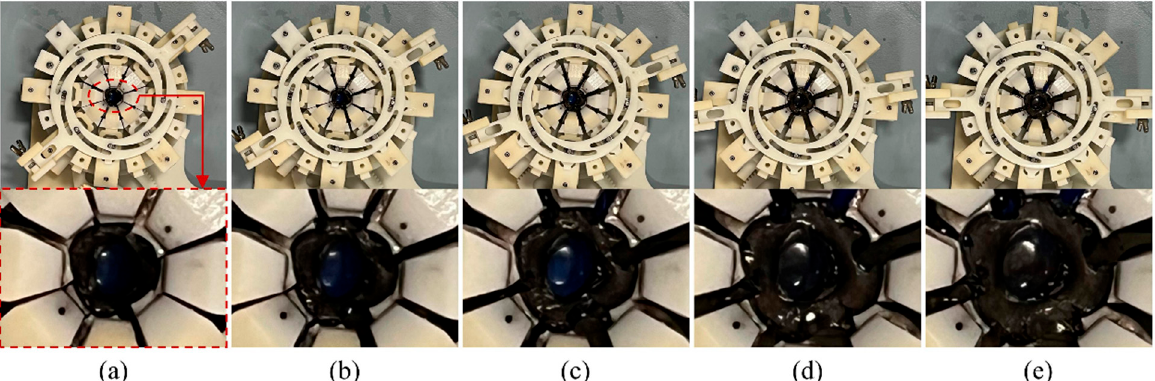
Figure 7. Images showing different degree levels of stretching for an anterior porcine eye sample. ( a ) the eight loading units are close to each other at the start of the stretching, the eight loading units move in distal directions with ( b ) showing zonular fibres in relaxed state, ( c ) showing zonular fibres in tensional state and ( d ) shown expansion of lens equatorial size, ( e ) the eight loading units at the maximal level of stretching.